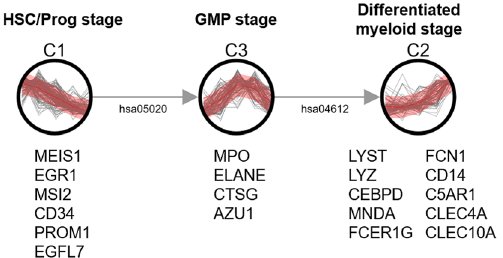
Figure 2. Cluster network of normal BM cells inferred by TRACS. 20 cell-type-specific genes that represent successive stages of normal hematopoietic development (HSC/Prog, GMP and differentiated myeloid stage (ProMono, Mono)) are shown below the assigned cluster. Here and in all following figures, each cluster is represented with a Gaussian process mean (solid red line) and variance (red area, 95% confidence interval) and edges between clusters are annotated with shared biological